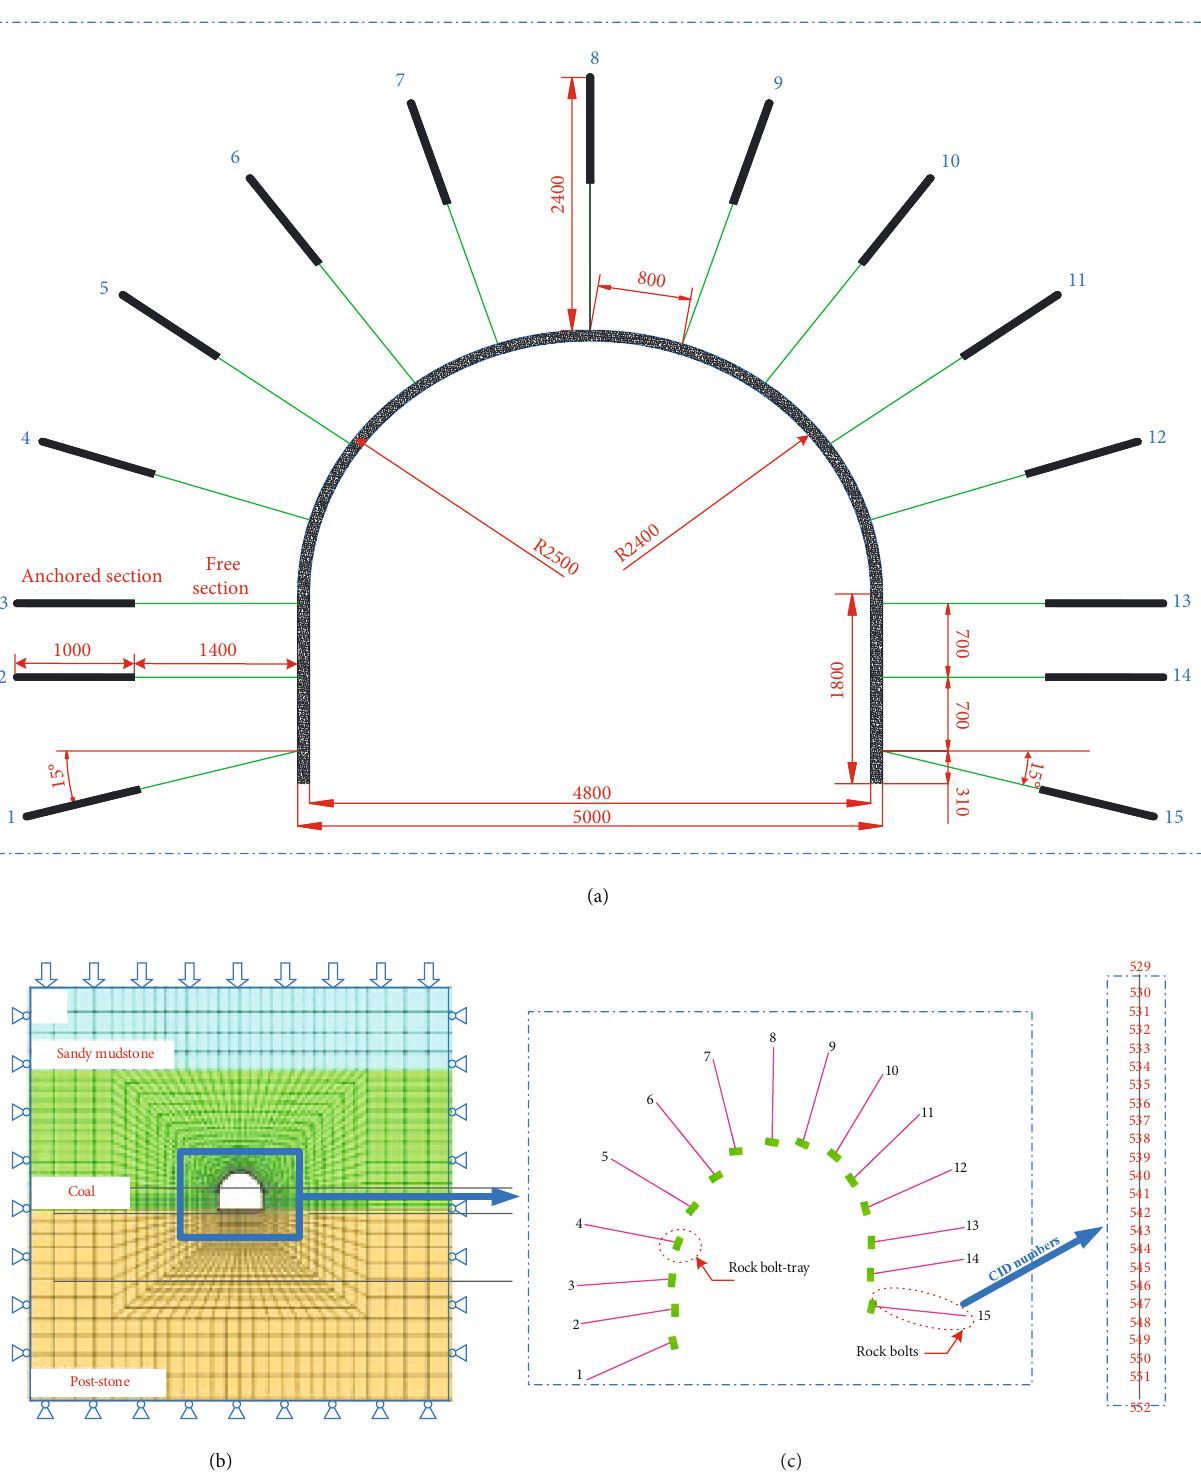
Figure 11: Detailed technical parameters and numerical calculation model and schematic diagram of the supporting constructional